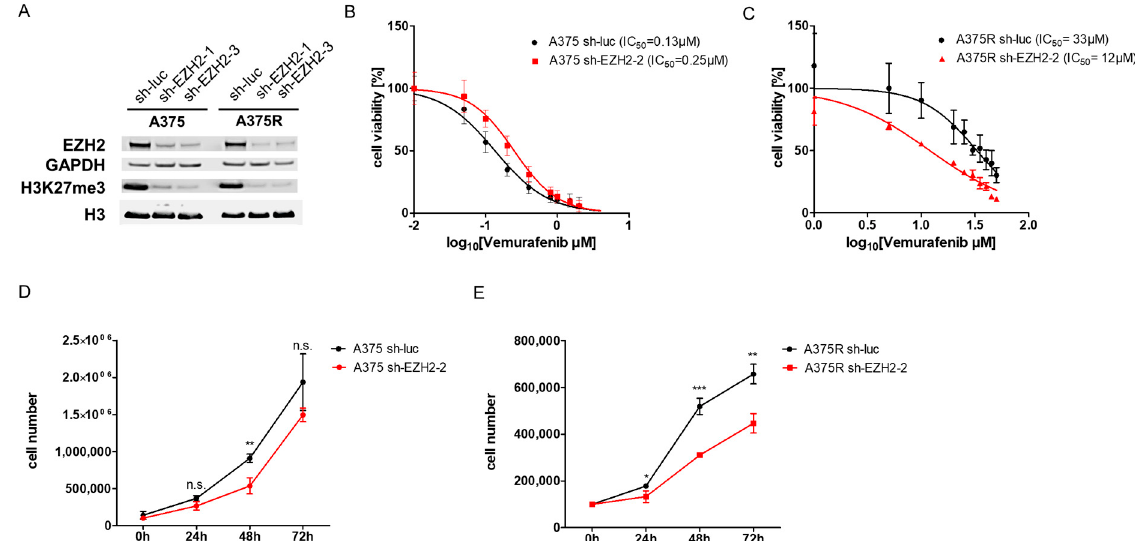
Figure 2. Knockdown of EZH2 improves response to vemurafenib of A375R cells. A375 cells and A375R cells were transfected with EZH2-specific shRNA constructs or control shRNAs. ( A ) Western blot of A375 cells and A375R cells, with stable knockdown of EZH2 (sh-EZH2) or control (sh-luc), examined EZH2, GAPDH, H3K27me3 and H3. Viability analysis of ( B ) A375 cells and ( C ) A375R cells, with stable knockdown of EZH2, treated with increasing concentrations of vemurafenib (Vem; A375 0-4 µM; A375R 0-50 µM). Cell proliferation of ( D ) A375 cells and ( E ) A375R cells with stable knockdown of EZH2. (** p < 0.01; *** p < 0.001; n.s.: not significant)